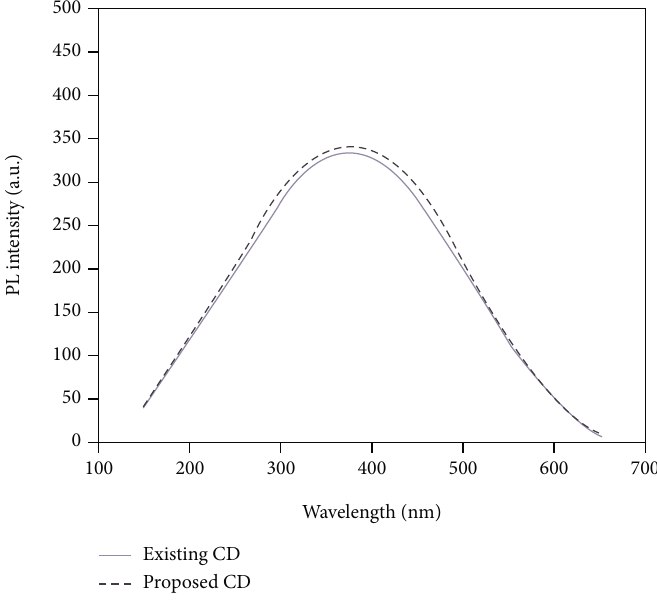
Figure 4: Wavelength vs PL